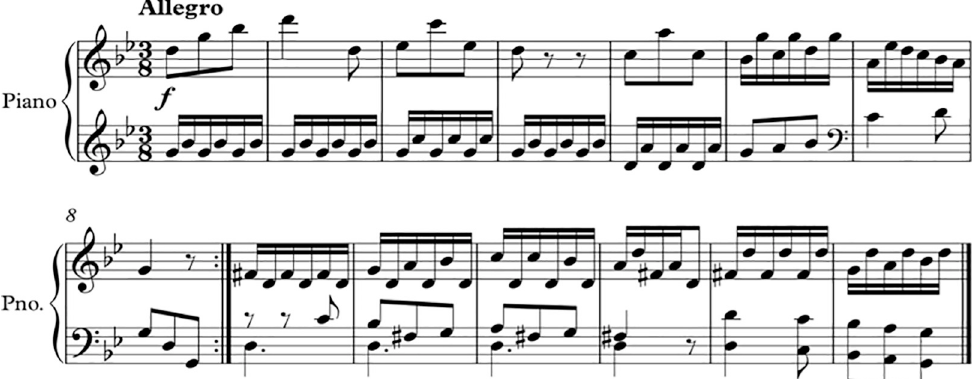
Fig 4. Excerpt of Haydn Hob 8. 4 th Movement—Altered (Minor